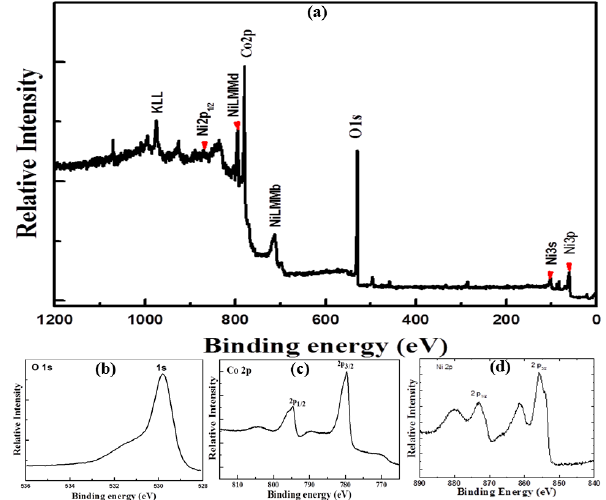
Figure 3. XPS spectrum of NiCo spectrum, ( c ) Co 2p spectrum, ( d ) Ni 2p